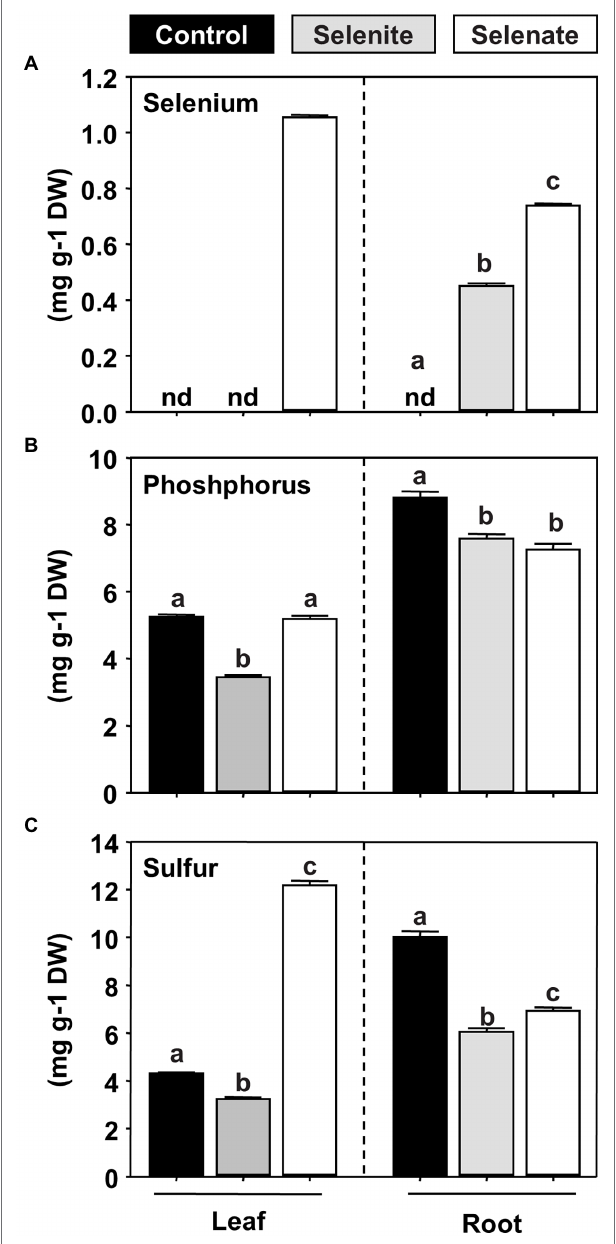
FIGURE 2 | Impact of selenite and selenate application on the partitioning of selenium, phosphorus, and sulfur in Arabidopsis. (A–C) Deposition of selenium (A) , phosphorus (B) , and sulfur (C) in leaves and roots of seven- week-old hydroponically grown plants challenged for one week with 50 μ M selenite (gray), 50 μ M selenate (white) or no additional selenium (Control, black). Different lowercase letters indicate individual groups identified by pairwise multiple comparisons with a Holm-Sidak one-way ANOVA ( p = 0.05, n = 3). n.d., not detectable, DW, dry